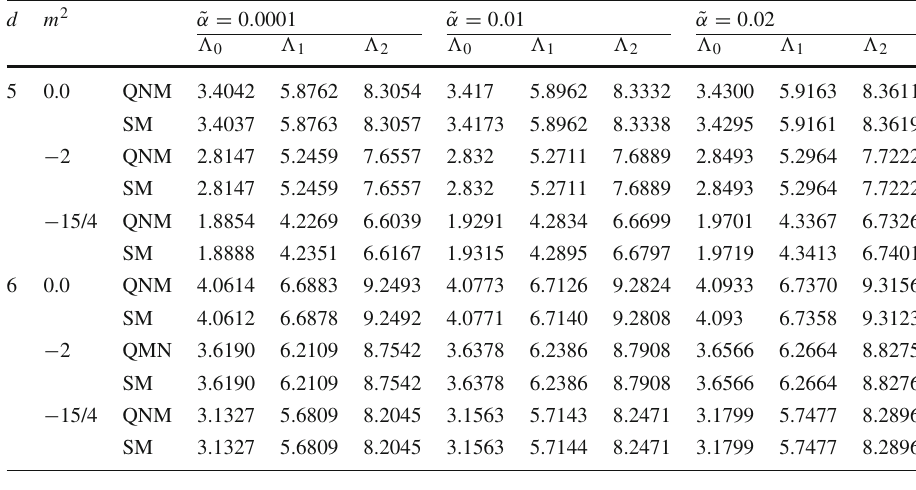
Table 3 First three lowest (cid:2) n ’s for Gauss–Bonnet gravity via the quasinormal modes (QNM) and shooting method